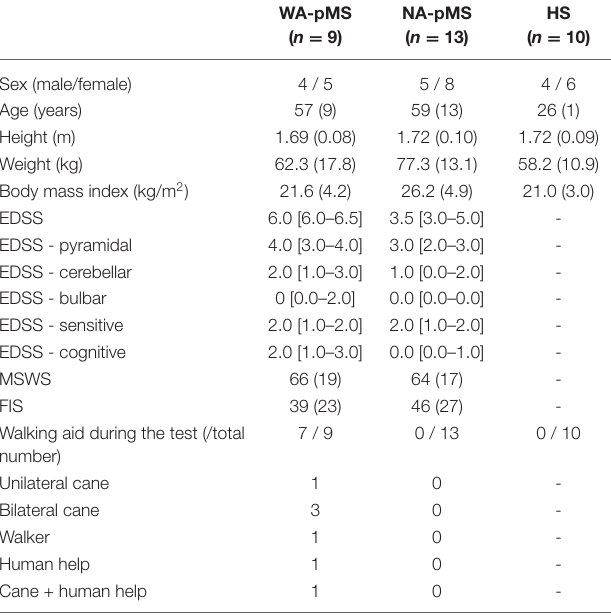
TABLE 1 | Baseline characteristics of participants from the three groups: progressive multiple sclerosis (pMS) and needing a walking aid (WA-pMS) and not needing a walking aid (NA-pMS) and healthy subjects (HS).